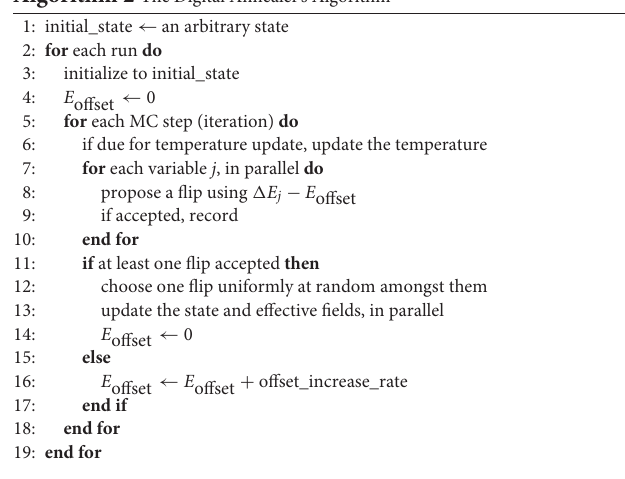
Algorithm 2 The Digital Annealer’s